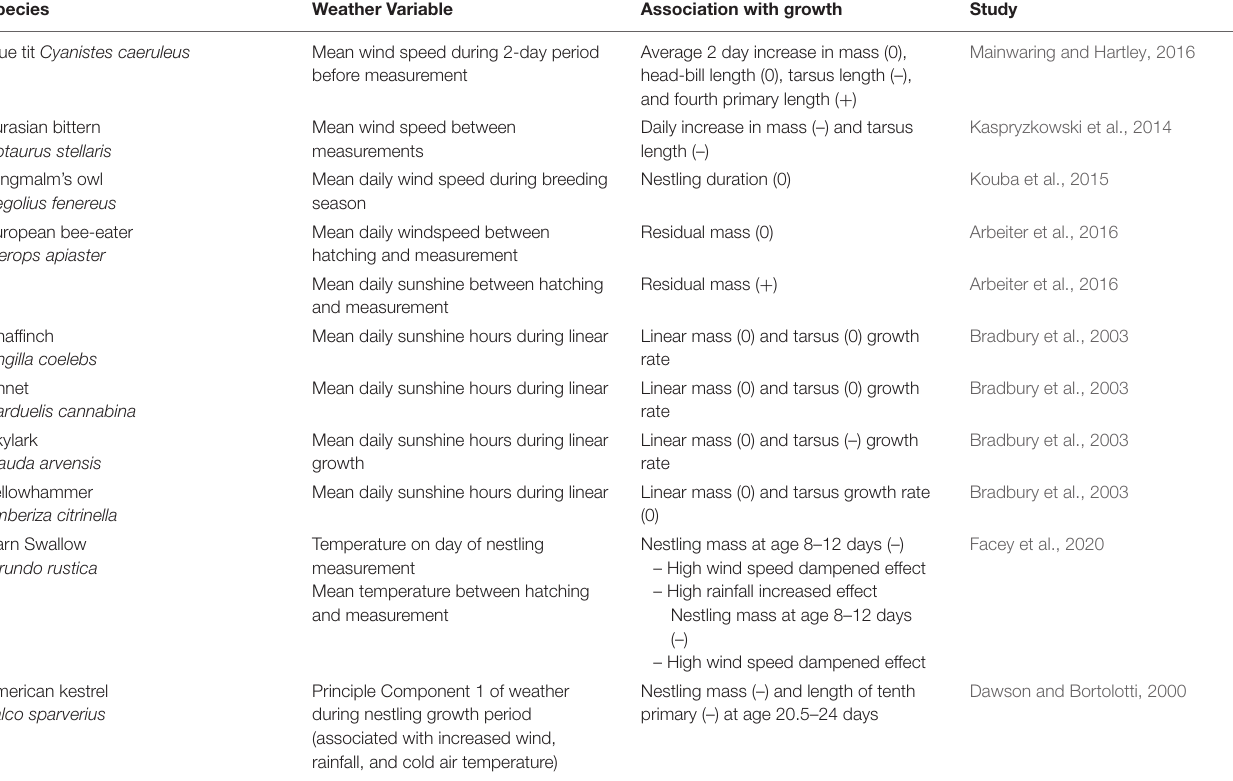
TABLE 3 | Associations between combined weather effects, wind speed, sunshine, and nestling growth traits identified from our literature